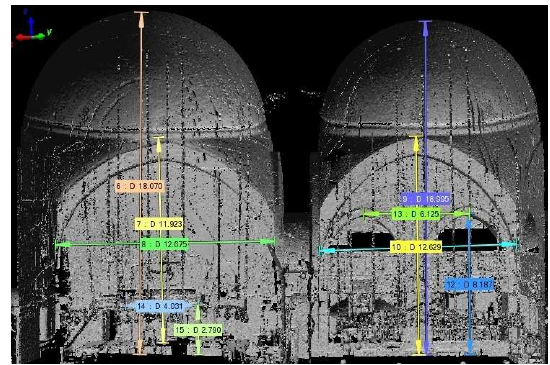
Figure 10. Point cloud (above) and ground plan (below) of the Mevlana Museum (units are meters).